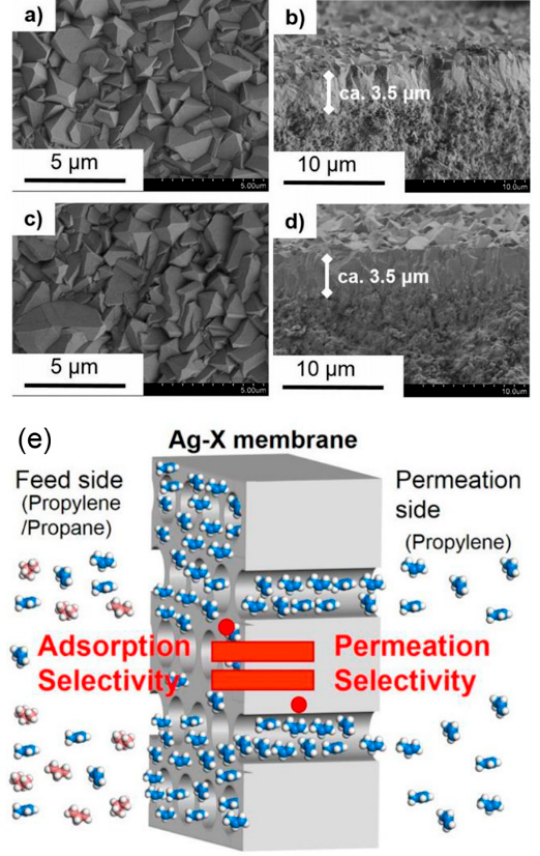
Figure 4. Typical field-emission scanning electron microscopy (FE-SEM) images of ( a , b ) Na-X and ( c , d ) Ag-X membrane ion exchanged with 10 mM AgNO 3 solution [56]. ( e ) Schematic illustration of the relationship between the adsorption selectivity and permeation selectivity of the Ag-exchanged zeolite membrane [57].